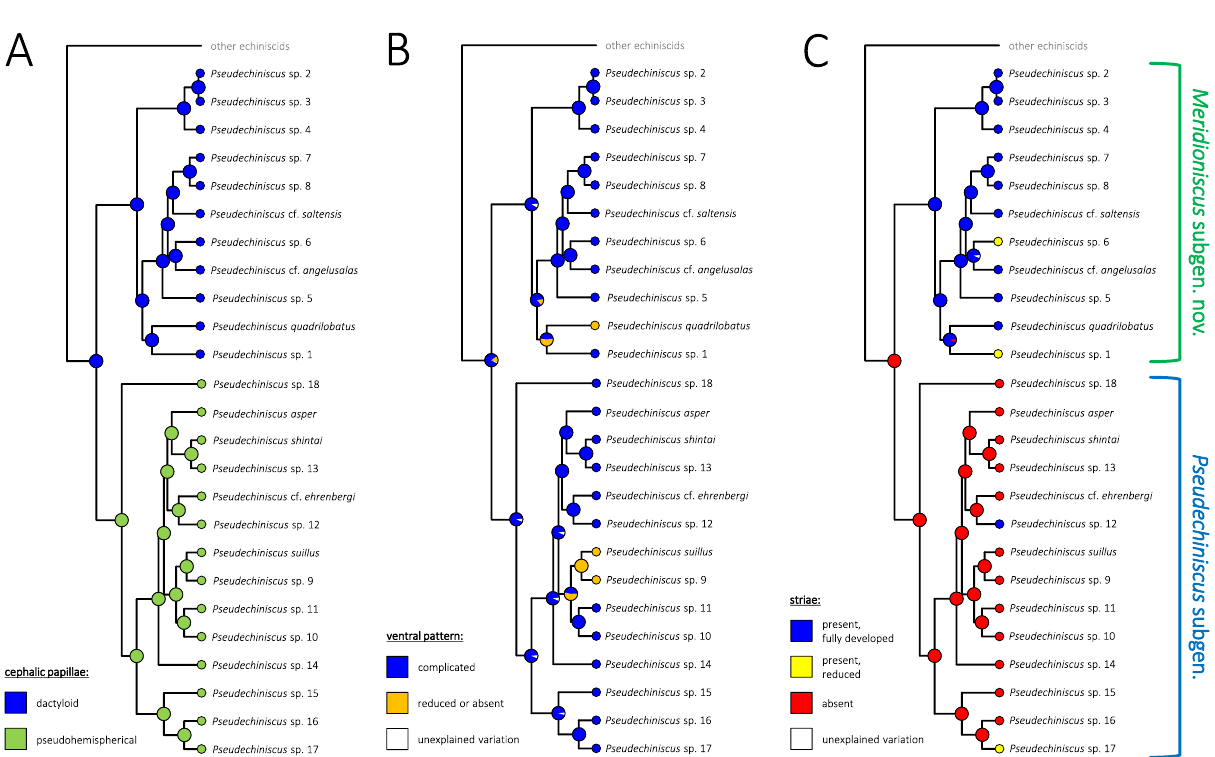
Figure 4. Ancestral state reconstruction and trait evolution in Pseudechiniscus : ( A ) the shape of cephalic papillae, ( B ) the type of ventral ornamentation, ( C ) the development of striae between endocuticular pillars. Pie charts illustrate the probability that a given character state occurred at a